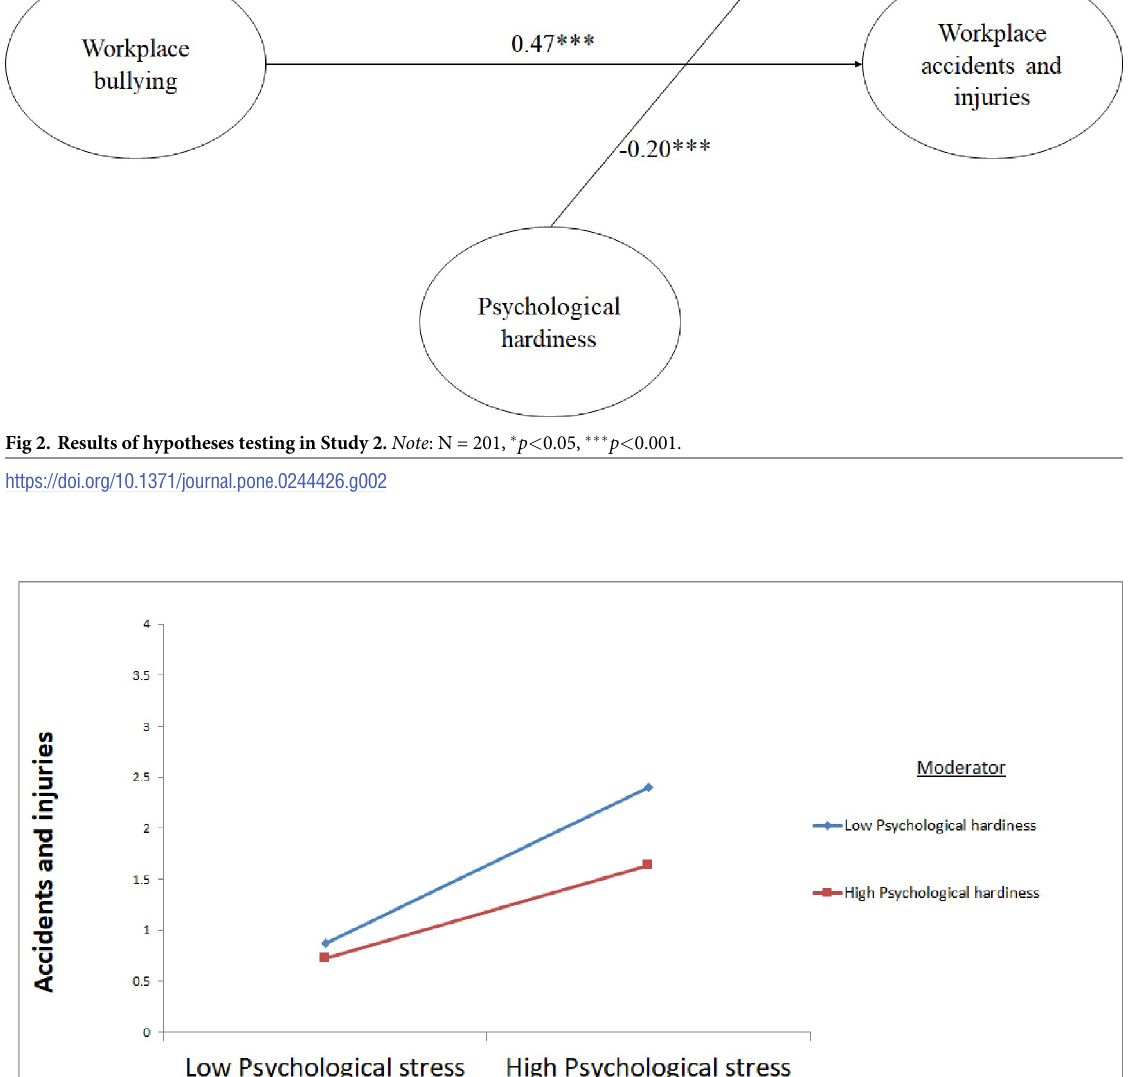
PLOS ONE | https://doi.org/10.1371/journal.pone.0244426 January 8,